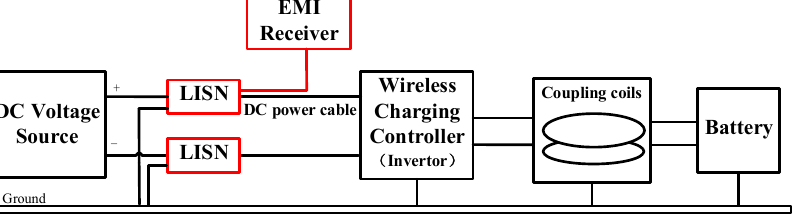
Figure 1. Conducted electromagnetic interference (EMI) emission system test setup for wireless charging system (WCS).